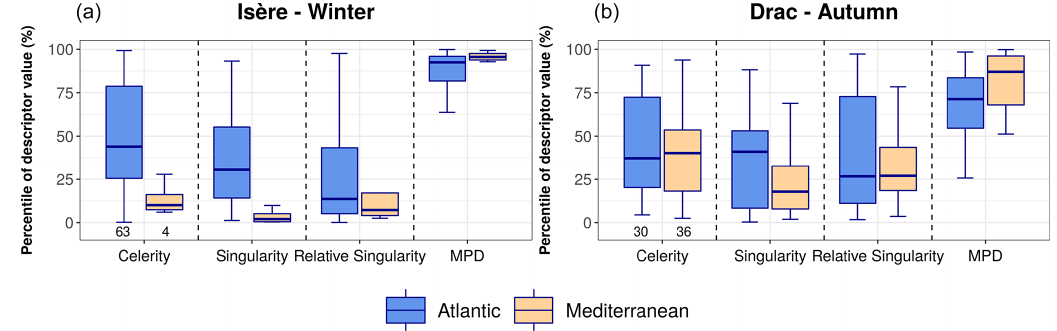
Figure 12. Percentile of descriptor value associated with the daily seasonal maxima of precipitation for the Isère River catchment in winter (a) and the Drac River catchment in autumn (b) , per atmospheric influence. Percentiles are computed with respect to the days associated with the given atmospheric influence over the period 1950–2017. The numbers in the bottom left of the graphs indicate the number of days considered in the Atlantic and Mediterranean